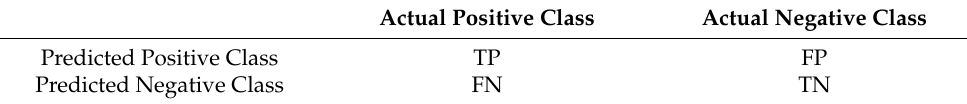
Table 1. A representation of the confusion matrix for binary classification purposes.